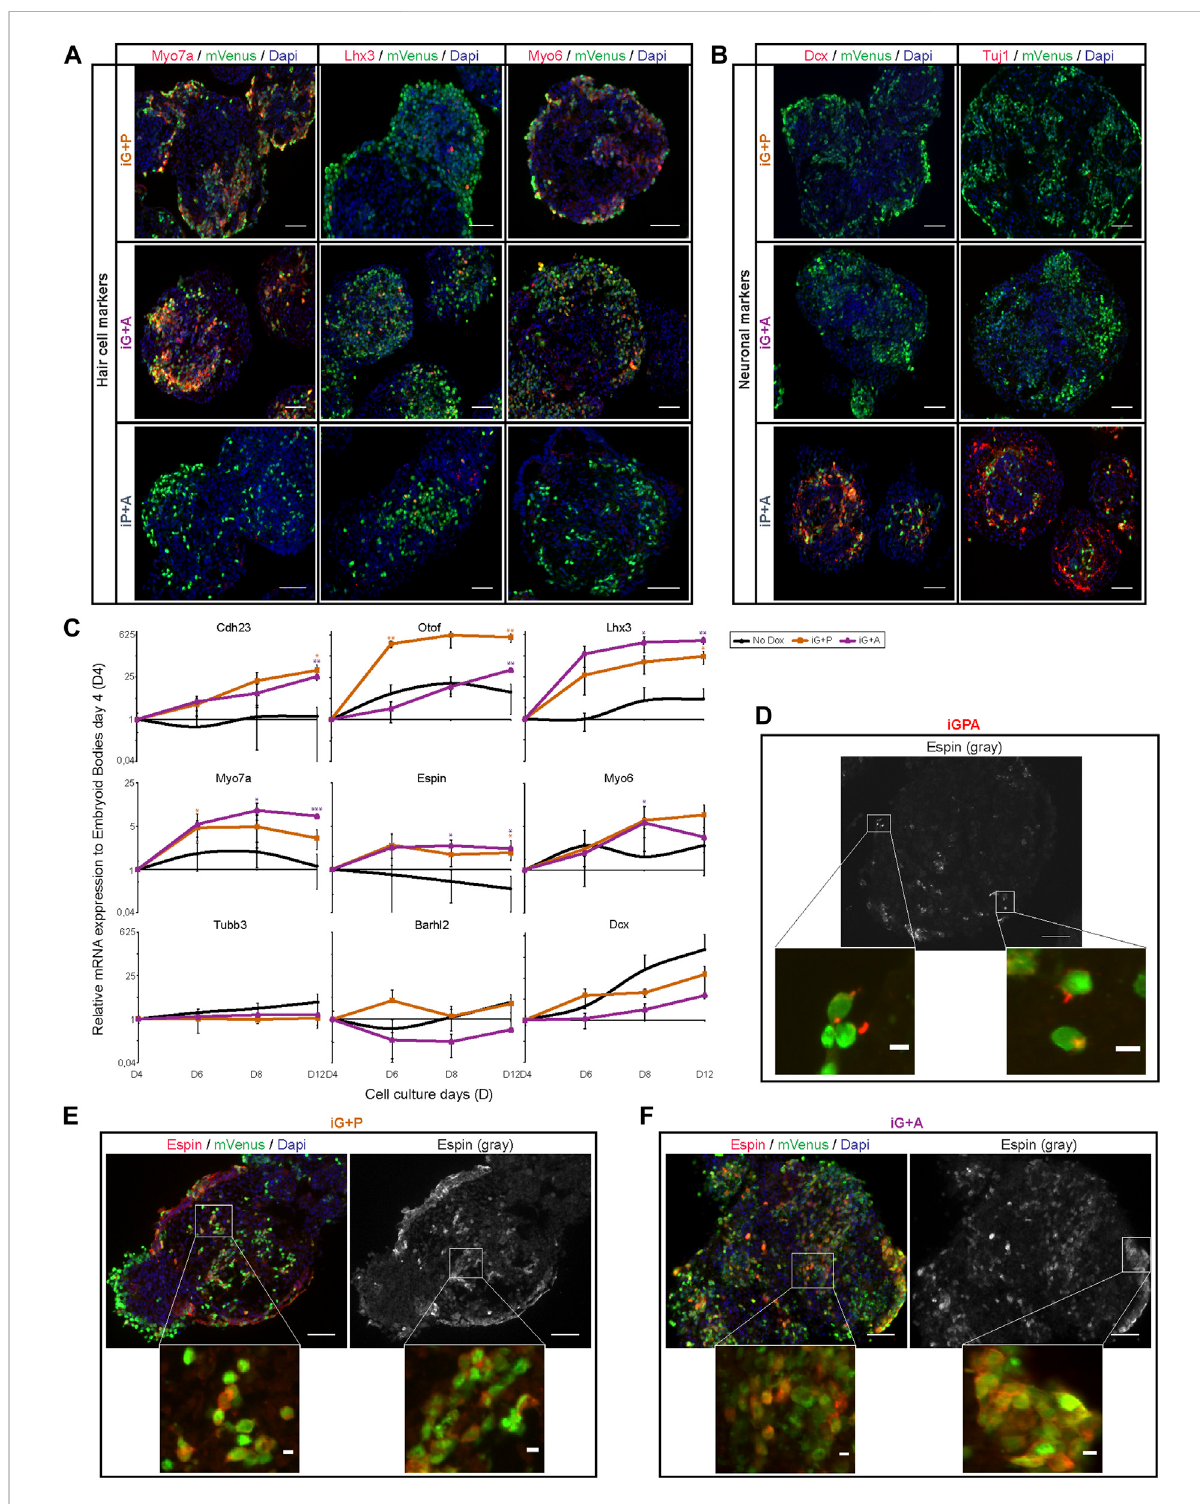
G fi 1 with Atoh1 or Pouf43 promotes HC gene expression but cellular differentiation requires all three TFs. (A) Representative images obtained from immunostaining ofHC markers (Myo7a, Lhx3, and Myo6) (red) in induced EBs atday 8of culture after 4 days of Doxtreatment.mVenus (green) indicates cells overexpressing the transgenic TF combination and nucleus are labelled by DAPI (blue). Scale bar, 50 µm. (B) Expression of neuronal markers (Dcx and Tuj1) (red) in the same induced EBs shown in (A) . Scale bar, 50 µm. (C) qRT-PCR analyses for HC markers (Cdh23, Otof,